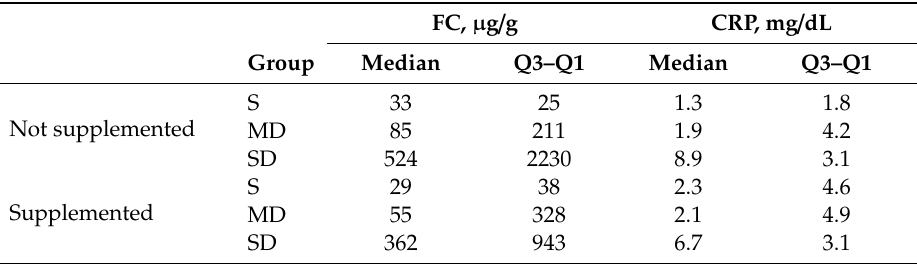
Table 4. Median and interquartile range of FC and CRP grouped by vitamin D levels for patients with and without vitamin D supplementation.